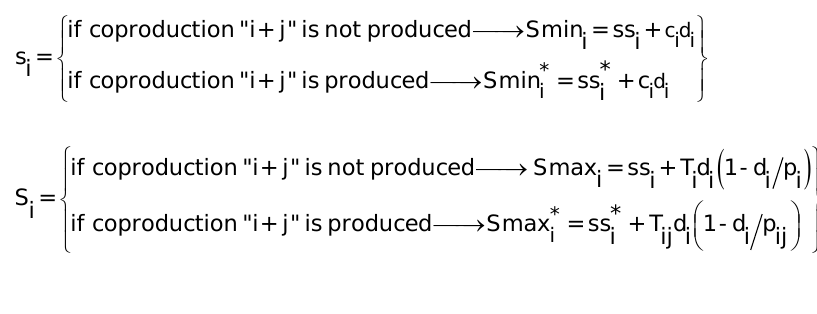
Equation 6. “Min Stock and Max Stock for the Economic Manufacturing Quantity with